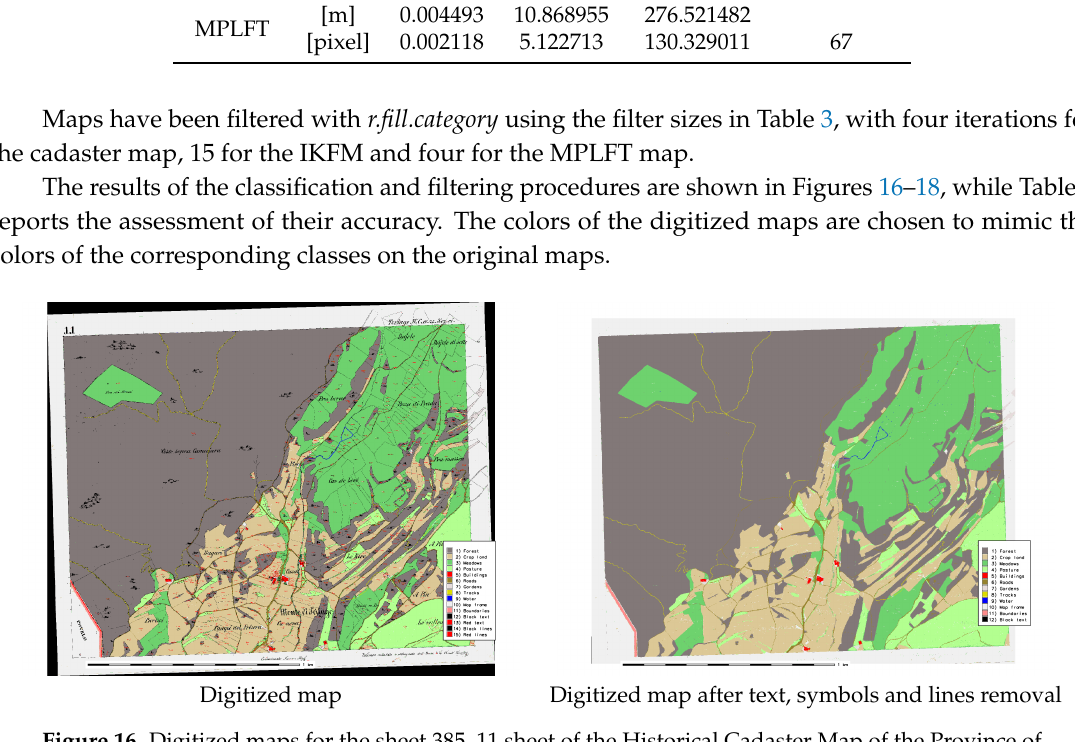
Figure 16. Digitized maps for the sheet 385_11 sheet of the Historical Cadaster Map of the Province of Trento, “Comune catastale di Terlago”, Simple Weighted Vote (SWV) voting